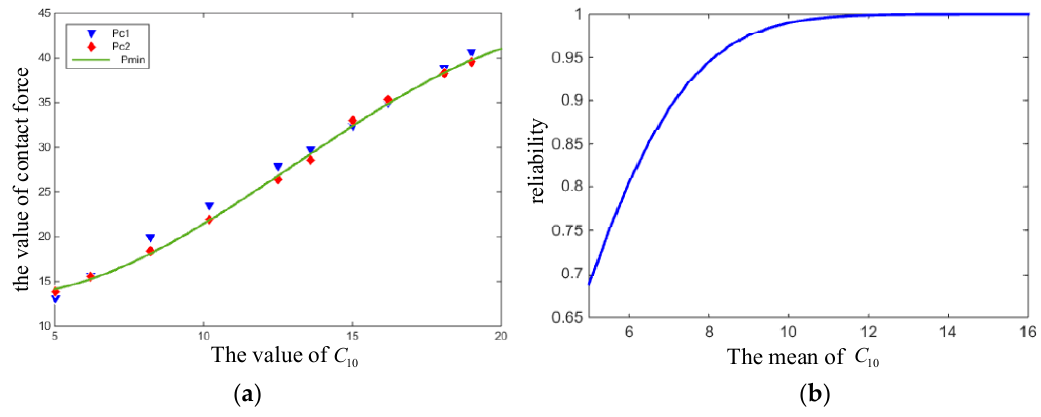
Figure 6. ( a ) Contact stress and ( b ) reliability with varying C 10 .